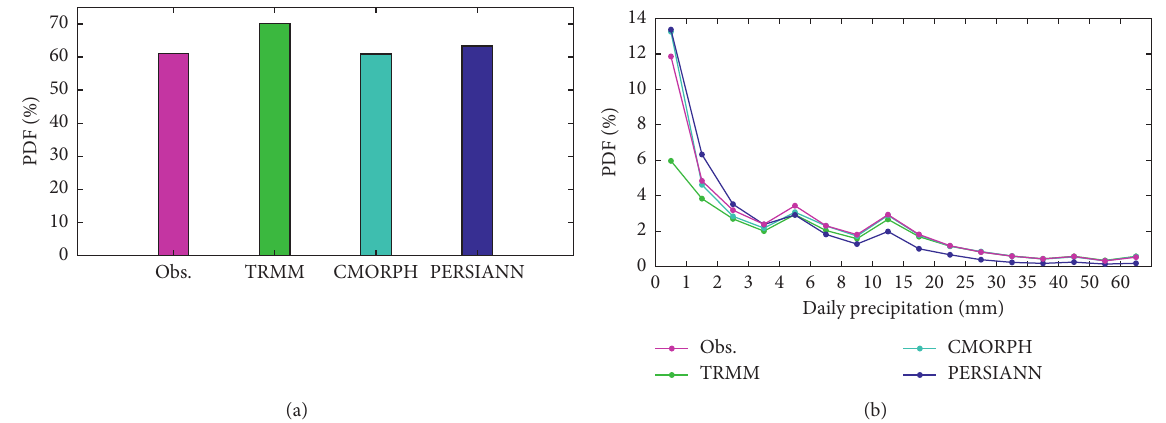
Figure 10: Probability density function of daily precipitation for (a) no-rain and (b) precipitation of different intensities derived from observation and satellite